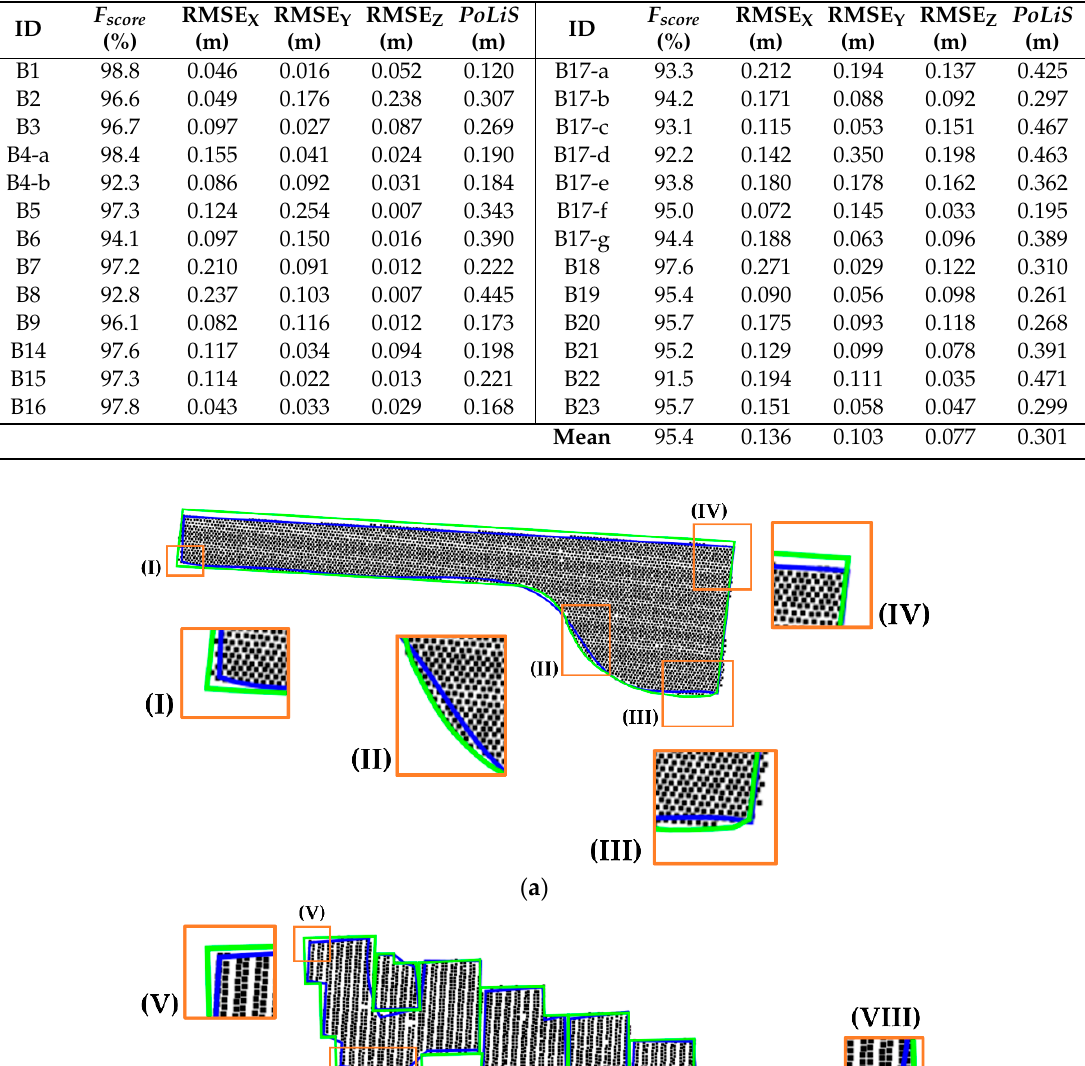
Table 1. Quality parameters using the iterative CD-spline regularization method for selected buildings from both datasets.